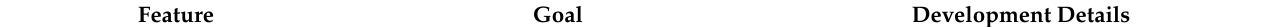
Table 4. The vision of the development of the New Center of Rokietnica according to the expectations of various stakeholders.